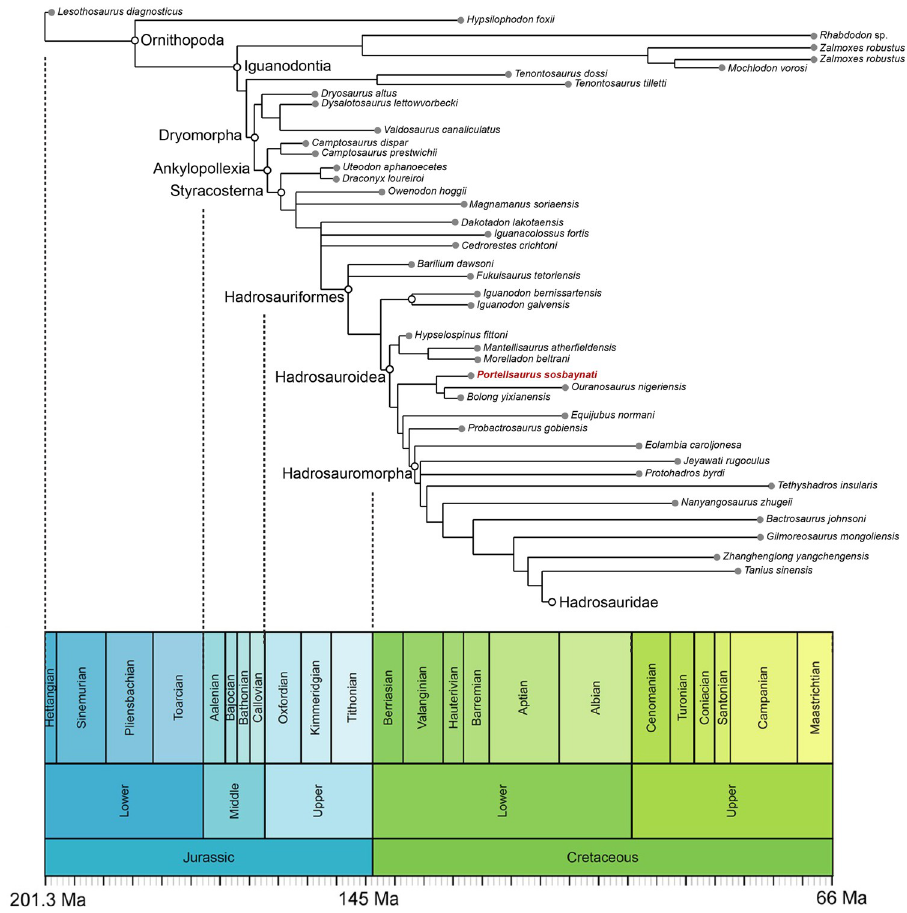
Fig 12. Time-calibrated relationships of Portellsaurus sosbaynati (MQ98-II-1). Time-calibrated strict reduced consensus tree resulting from the analysis of the modified data matrix from Verdu´ et al. [7]. Each taxon is plotted stratigraphically based on its first appearance